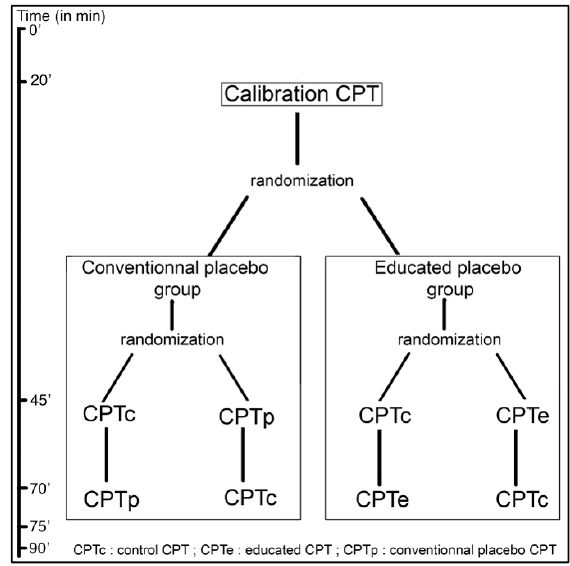
Figure 1. CPT order diagram.